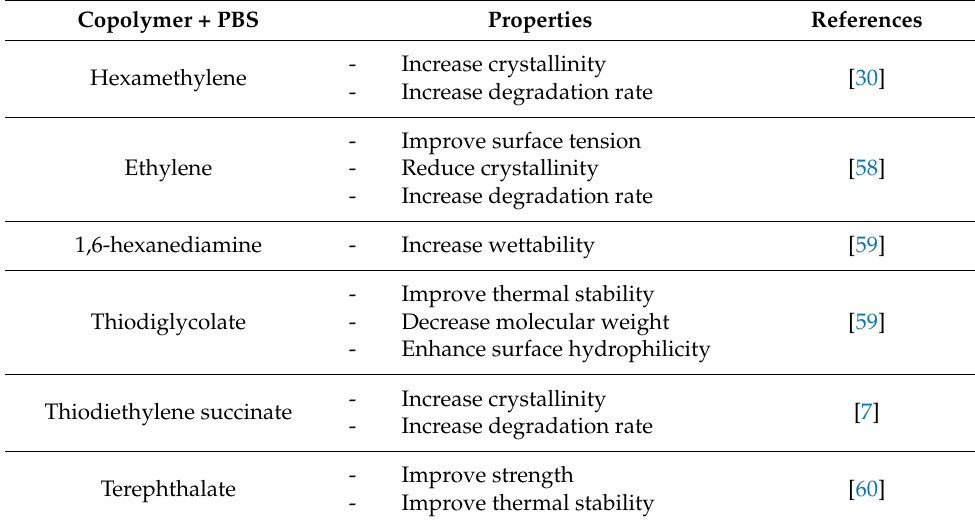
Figure 10. Synthesis of the aliphatic copolyesters of poly(1,4-cyclohexanedimethanol-co-isosorbide 2,5-furandicarboxylate) [47]. Adapted with permission from Kasmi et al. (2018). Table 2. Properties of blended PBS with different